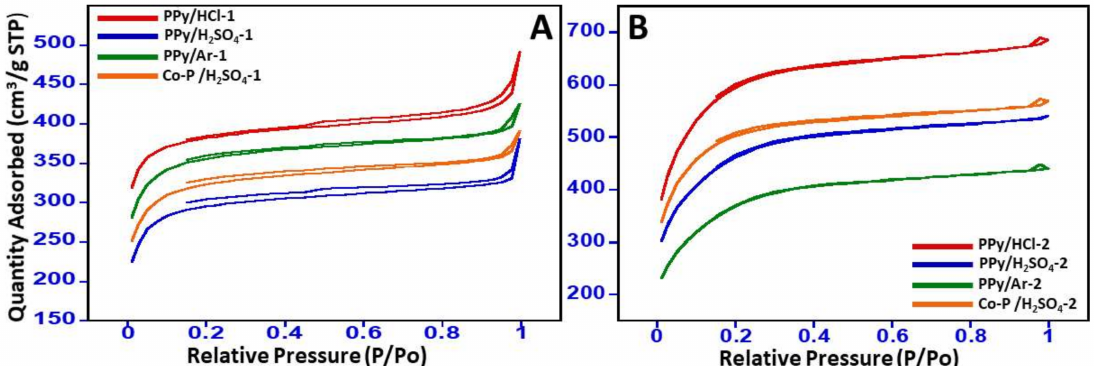
Figure 3. Adsorption/desorption isotherms obtained for ( A ) N-GOs obtained when carbonization and activation were carried using polymer: KOH at a ratio of 1:2; ( B ) N-GOs obtained when carbonization